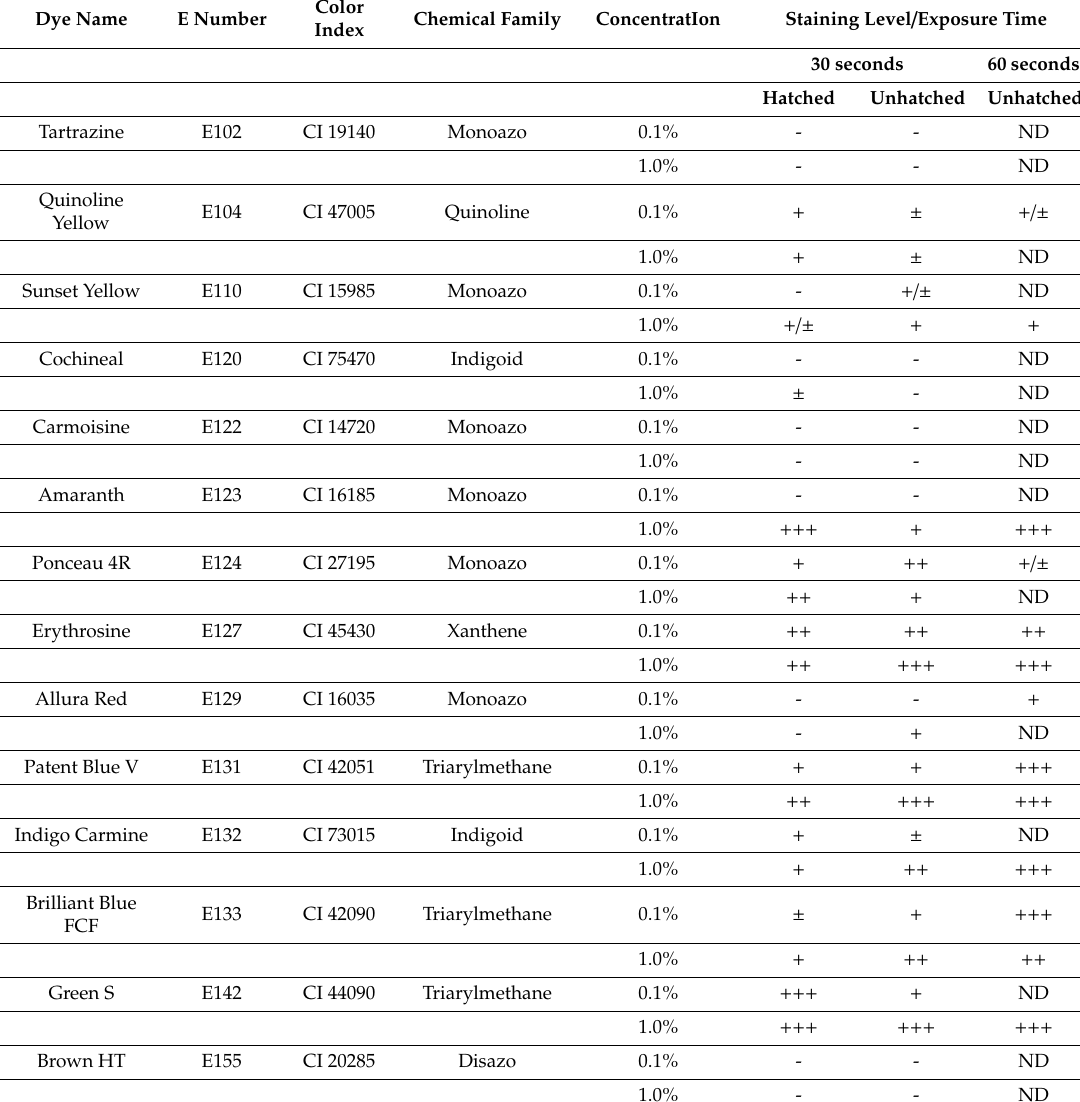
Table 1. Staining e ff ects of various dyes applied to intact and hatched human louse